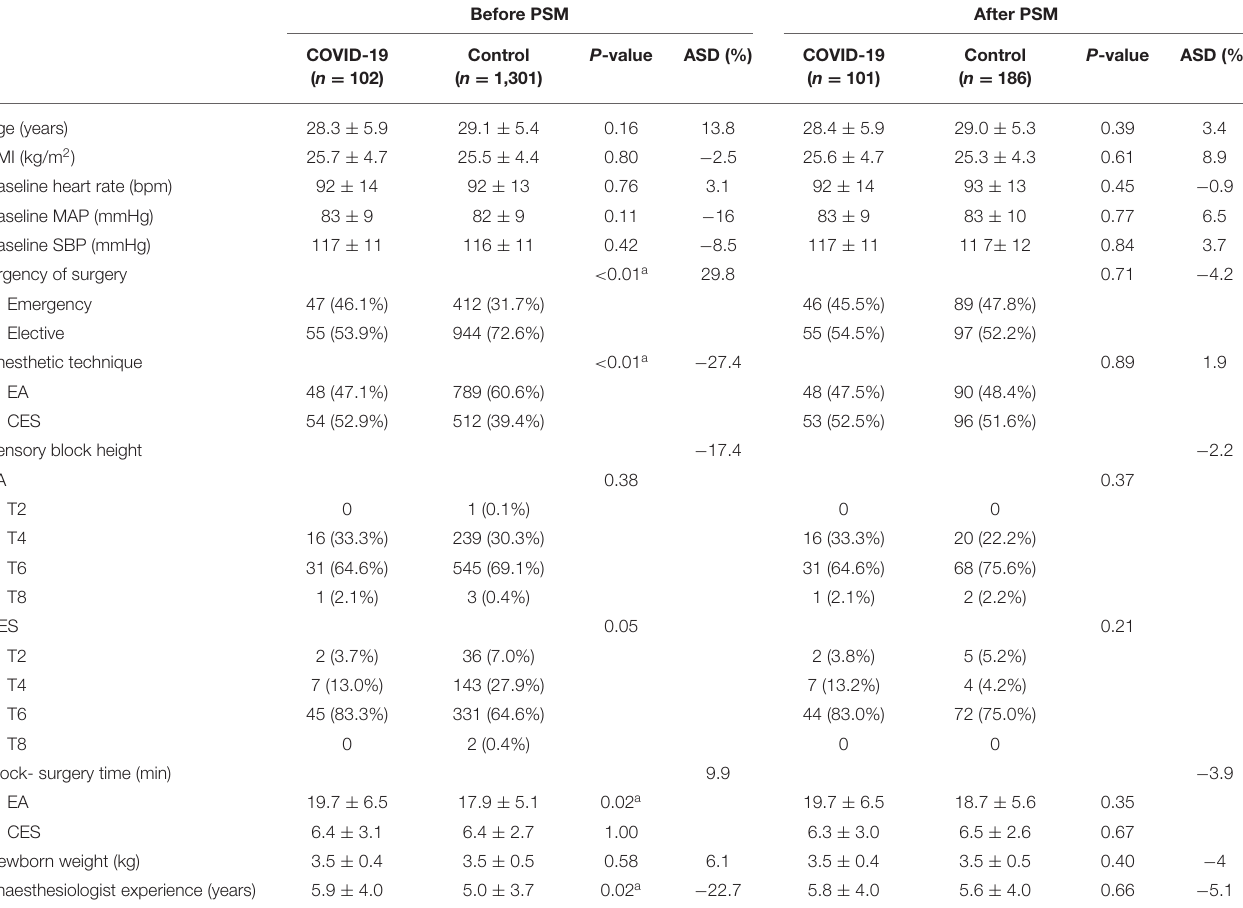
TABLE 1 | The characteristics of predictors for neuraxial anesthesia-related hypotension in parturients before and after propensity score matching (PSM). Before